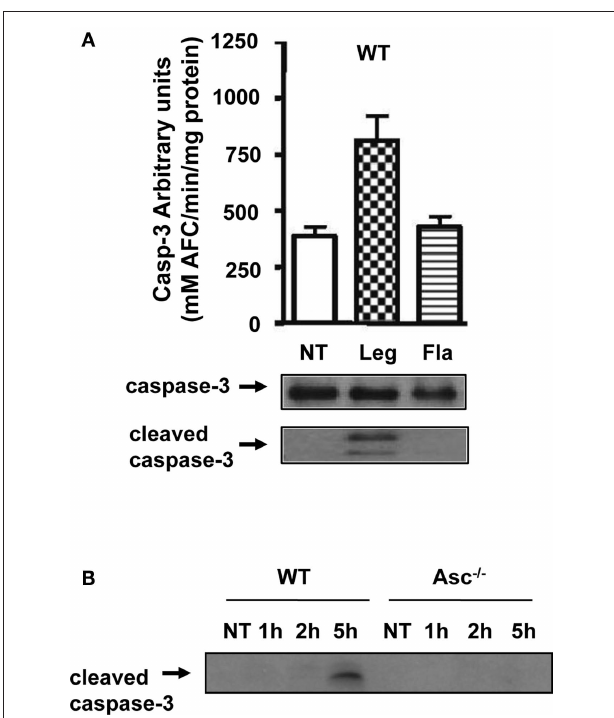
Figure 6 | (A) Lysates from WT macrophages infected with L. pneumophila (Leg), the Fla mutant, or the type IV secretion mutant DotA were used to determine caspase-3 activity by the DEVD-AFC assay, or inactive full-length (FL-casp-3) and cleaved caspase-3 (cleaved casp-3) by immunoblotting. (B) WT and Asc − / − macrophages were infected with Fla mutant for 1, 2, and 5 h then cell lysates were obtained and used to determine cleaved caspase-3 by Western